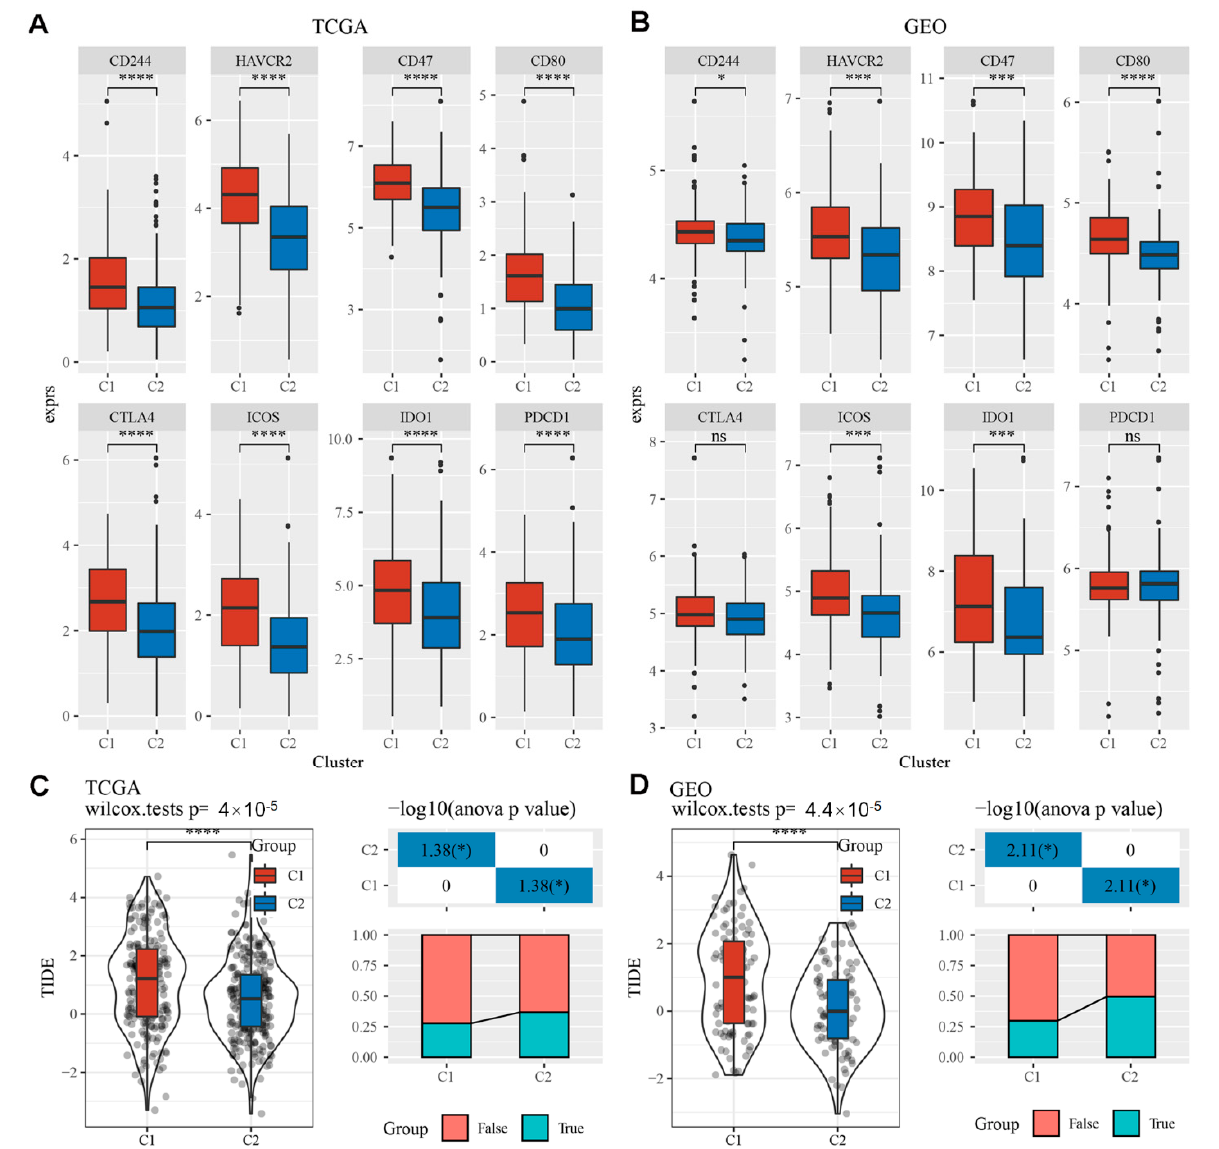
Figure 6. Differential analysis of immunotherapy in EMT-associated lncRNAs subgroups. The boxplots demonstrate immune checkpoints that were upregulated in cluster 1 compared with cluster 2 in TCGA ( A ) and GEO ( B ). ( C ) Differences in TIDE scores and immune response status among different molecular subtypes of TCGA. ( D ) Differences in TIDE score and immune response status among different molecular subtypes in GEO cohort. Ns; p > 0.05; * 0.01 ≤ p < 0.05; *** p < 0.001, **** p <